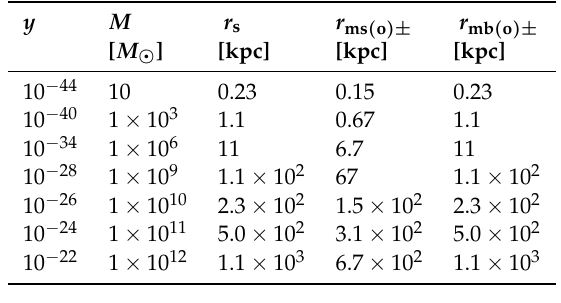
Table 1. Mass parameter, the static radius and radii of the outer marginally stable and outer marginally bound circular orbits of the extreme KdS black-hole spacetimes with current value of the “relic” as r mb ( o )+ < r s in general, but for presented values of the cosmological parameter y these pairs of radii are